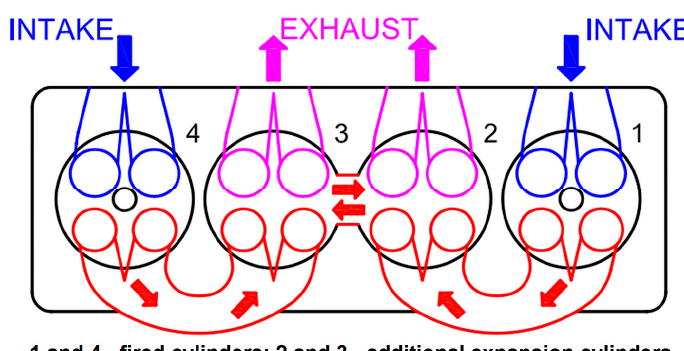
Figure 2. Scheme of the engine with an additional expansion process developed at Cracow University of Technology.